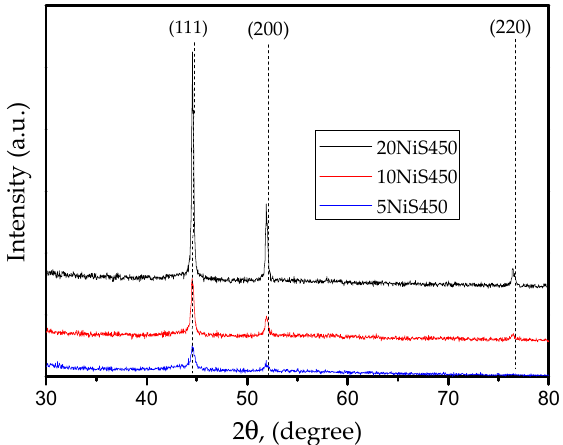
Figure 3. TEM image of the 10NiS450 catalyst.